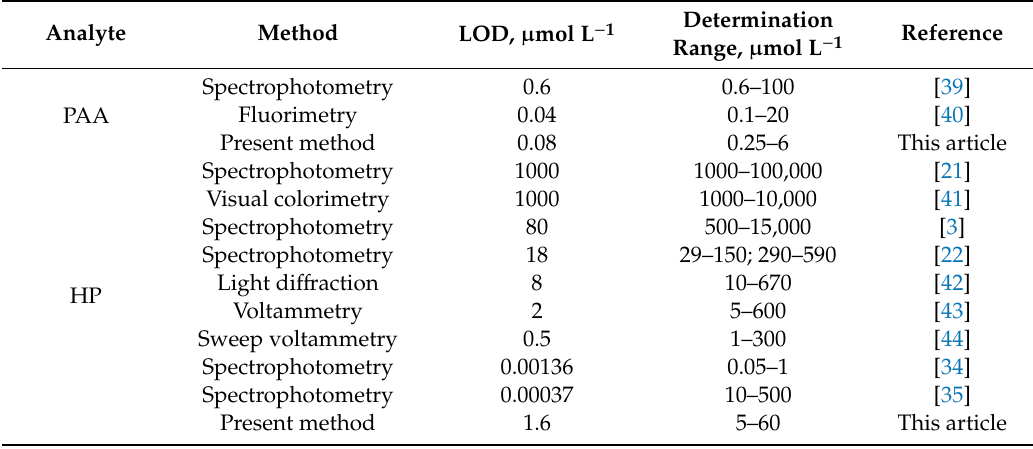
Table 5. Comparison of AgTNPs-based method with other methods for peroxides determination.